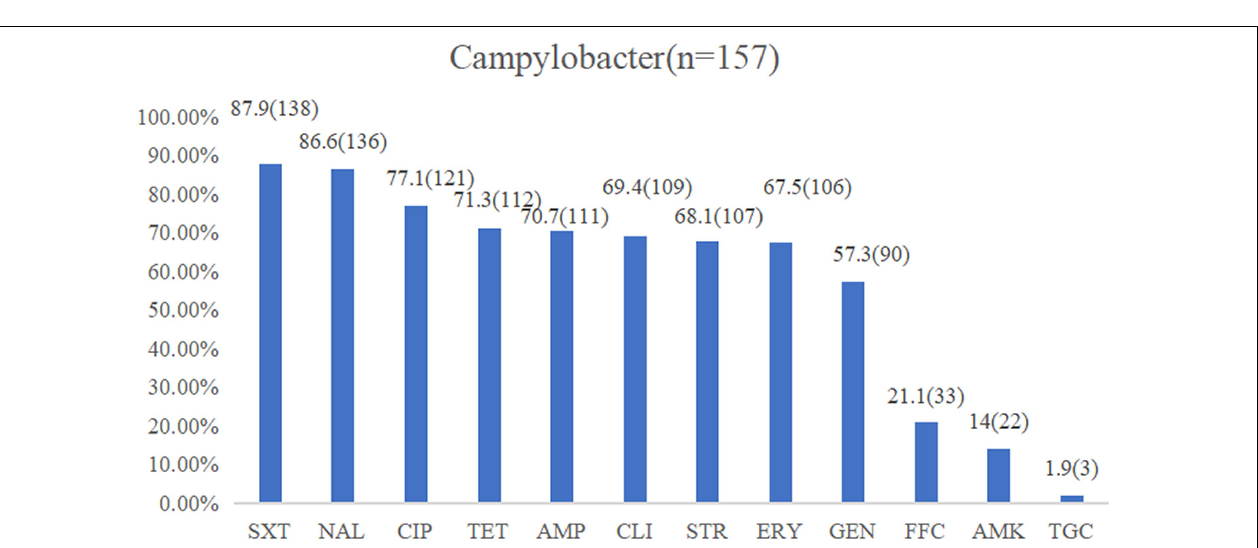
FIGURE 1 | (A) Prevalence of C. jejuni isolates ( n = 69) in the slaughtering line. A Fisher’s exact test was used for the categorical variables. *** P < 0.01, * P < 0.05. (B) Prevalence of C. coli isolates ( n = 84) in the slaughtering line. A Fisher’s exact test was used for the categorical variables. *** P < 0.01, ** P < 0.05.